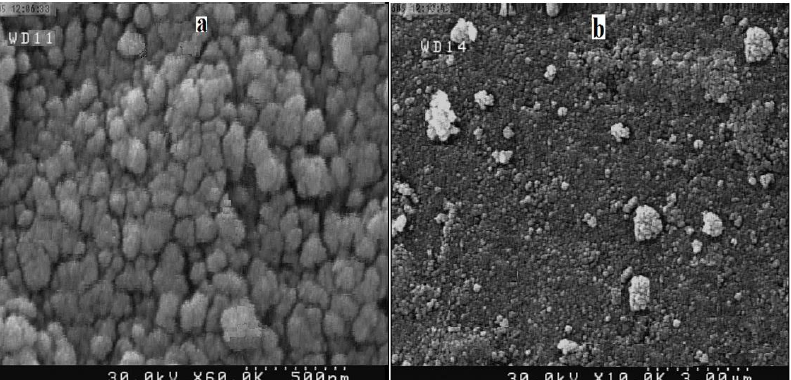
Fig. 5. SEM images of magnetite-ascorbic acid Fig. 5